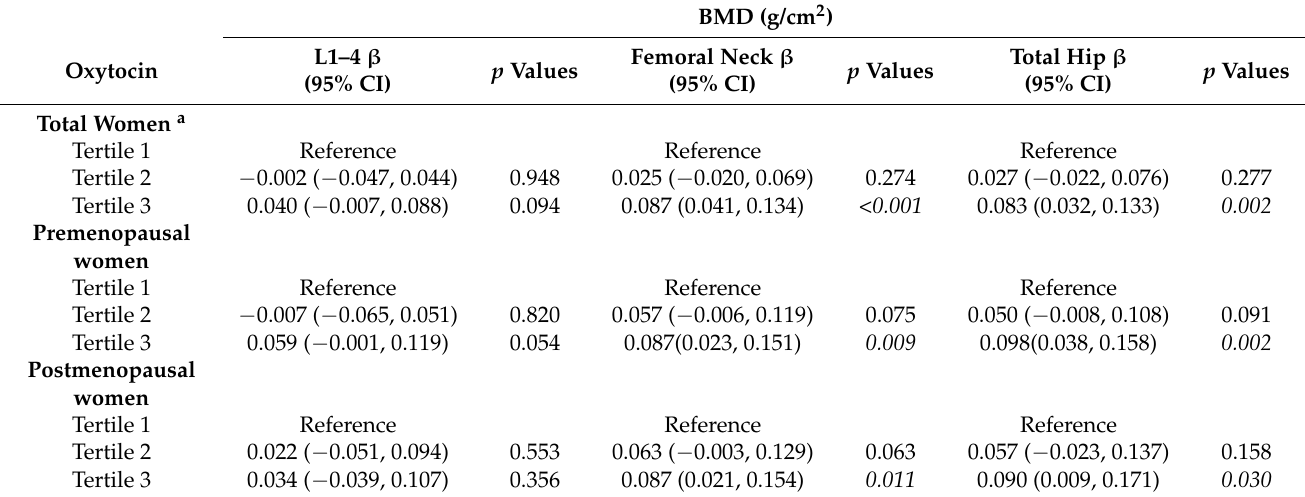
Table 2. Association between serum oxytocin levels and BMD in Chinese adult women by menopausal